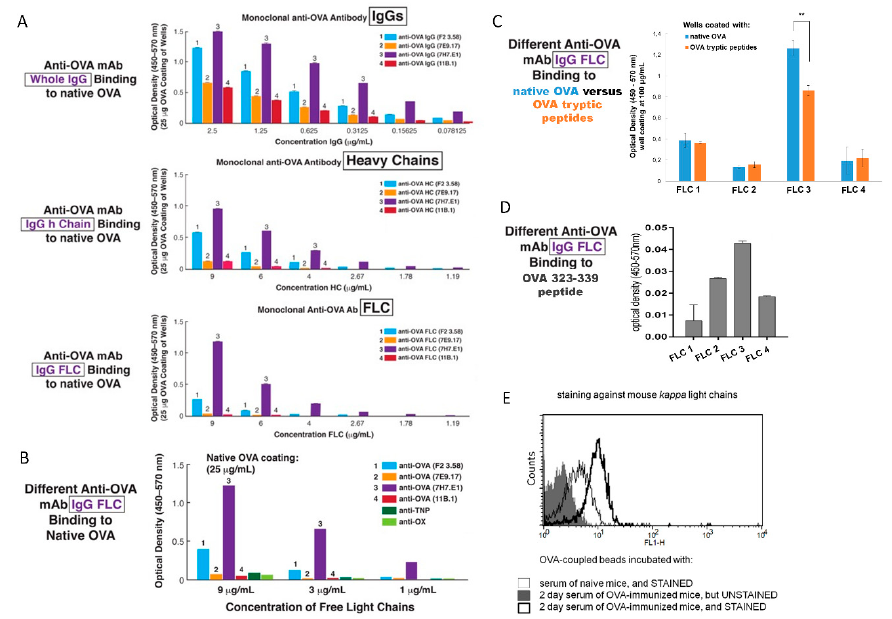
Figure 6. ELISA assays to assess the ability of four di ff erent monoclonal anti-OVA Ab-derived free light chains (FLC) to bind to native OVA, OVA tryptic peptides, and OVA 323-339 peptide, as well as flow cytometry analysis of anti-OVA Ab FLC in 2-day immune serum. ( A ) Binding to native OVA by serial dilutions of four different monoclonal anti-OVA Ab-derived FLC and Ab heavy chains, vs. the whole IgGs, shows significant binding with a particular mAb and similar strength with a given mAb and its derived heavy and light chains. ( B ) Binding of various monoclonal anti-OVA Ab FLC to native OVA compared to binding of control anti-OX and anti-TNP hapten-specific mAb shows the Ag specificity of the anti-OVA Ab FLC binding. ( C ) Comparison of binding of four monoclonal anti-OVA Ab-derived FLC to either native OVA or OVA tryptic peptides, showing a difference only in the case of FLC 3. The two-tailed Student t test, ** p < 0.01. ( D ) Binding of four monoclonal anti-OVA Ab-derived FLC to OVA 323-339 antigenic determinant. ( E ) The presence of OVA Ag-specific Ab FLC in 2-day serum of OVA-immunized mice (thick black line) was confirmed by flow cytometry, as compared to serum of control non-immunized mice (thin black line). n = 3 wells or samples in each experimental repetition.